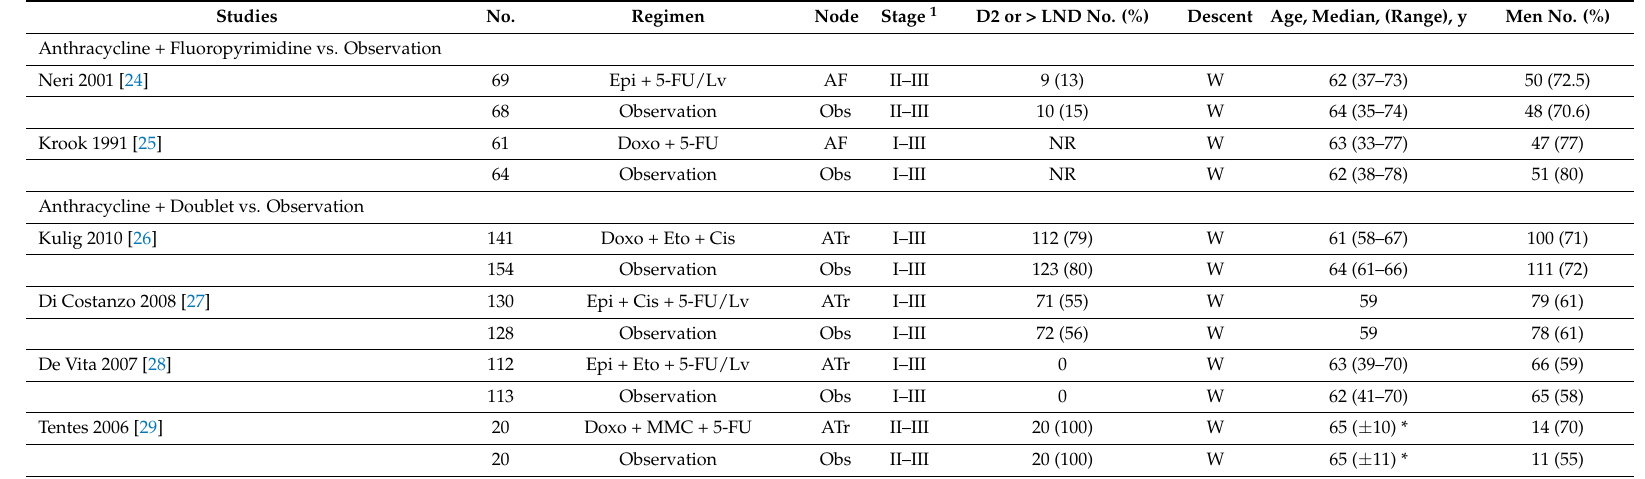
Table 2. Baseline characteristics of studies included in the adjuvant therapy for curatively resected gastric cancer network meta-analysis